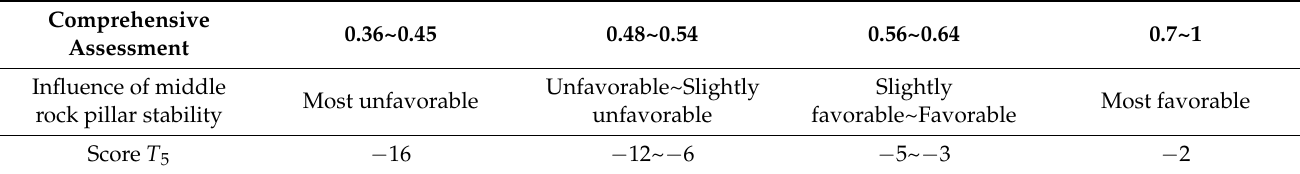
Table 10. Width–span ratio score of the middle rock pillar. Table 11. Score of the combination of the main structural plane and tunnel